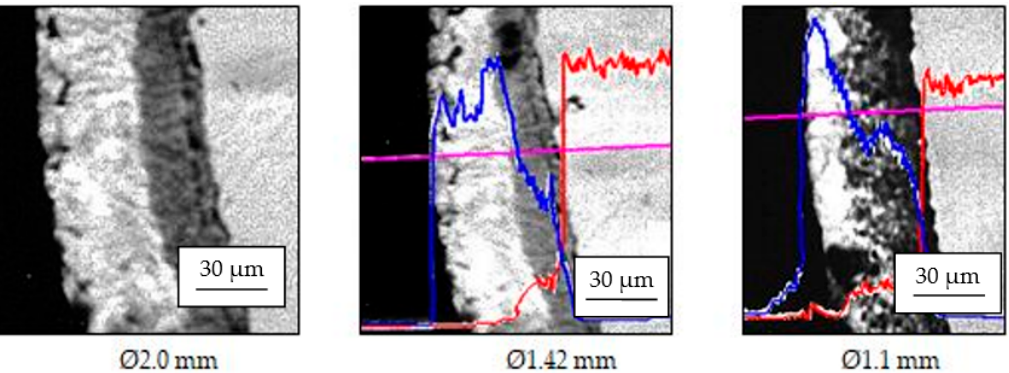
Figure 6. The structure of the Zn layer (deposited on variant 1) on the steel wire surface; the compositional profile of Zn (blue) and Fe (red), along its drawing on analysis line (purple).